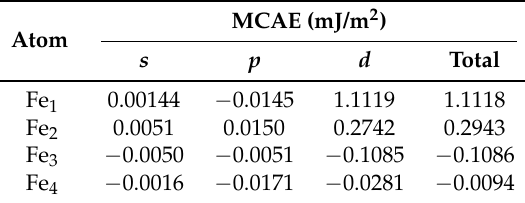
Table 3. Orbital-resolved MCAE for the